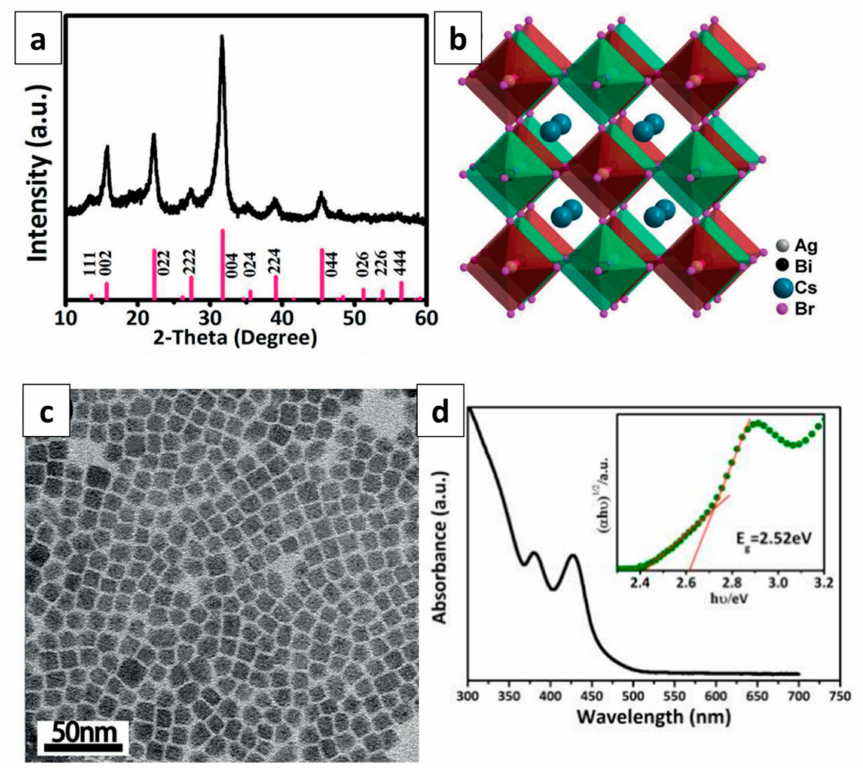
Figure 9. ( a )XRD patternof Cs 2 AgBiBr 6 NCs synthesized at200 ◦ C.( b )Crystal structure ofcubic Cs 2 AgBiBr 6 . ( c ) TEM image of Cs 2 AgBiBr 6 NCs, ( d ) UV-Visible spectra of colloidal Cs 2 AgBiBr 6 NCs, and the inset shows the Tauc plots. Reproduced with permission from Ref. [64], Copyright (2018) John Wiley and